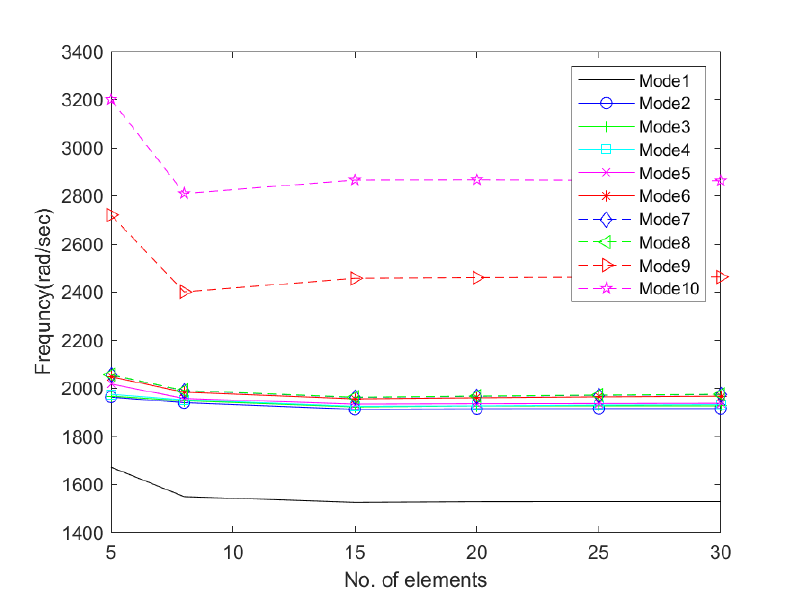
Figure 31. Convergence of natural frequencies of Timoshenko beams in Topology 1 with hinged ends. Table 7. Natural Frequencies, ω ( rad / s ) of Timoshenko beam Analysis with Hinged ends in Topology 1, 12% spanwise expanded configuration